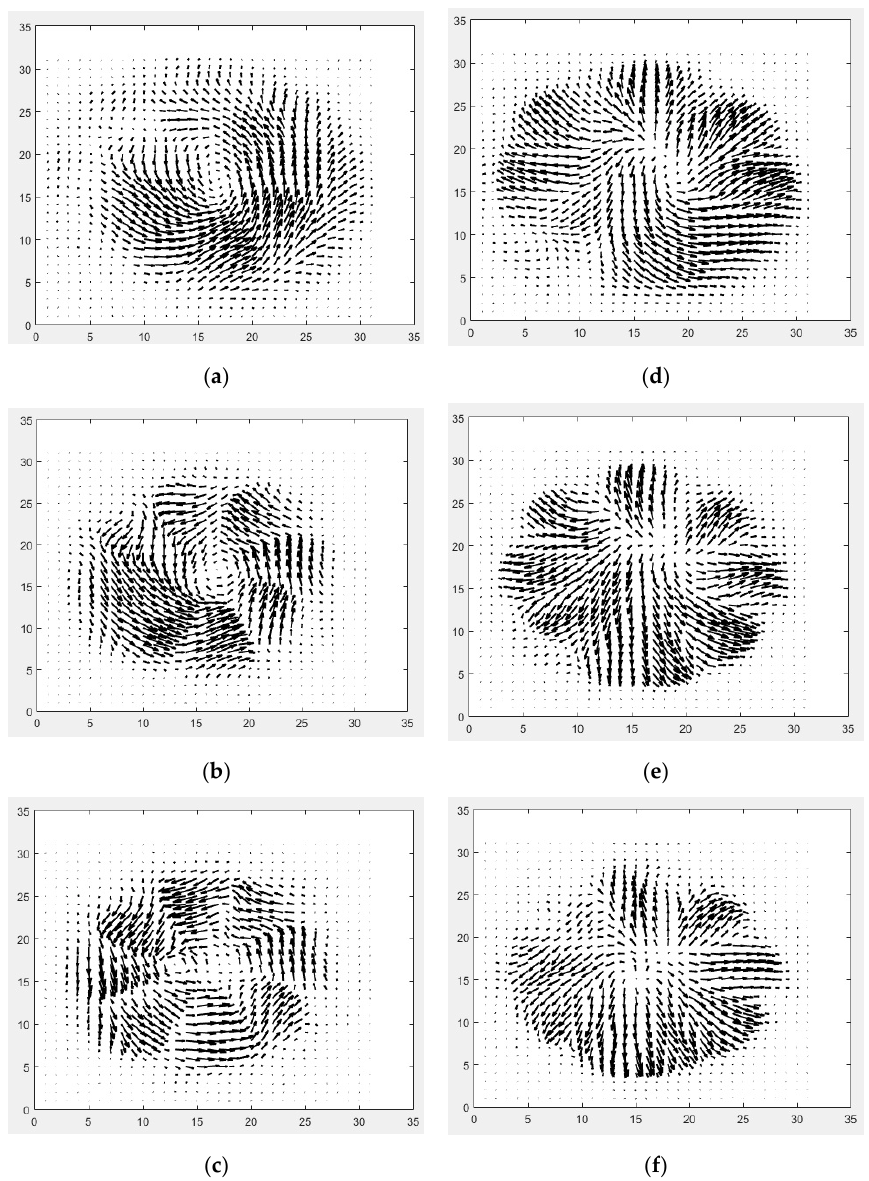
Figure 5. Vector fields corresponding to the E-Field multi-modal response of the q-plate at four main orientations with respect to the fast axis: azimuthal wavefront at 0° ( a – c ) and radial wave front at 90° ( d – f ) (133, 200 and 266 GHz, respectively). ( d – f ) (133, 200 and 266 GHz,